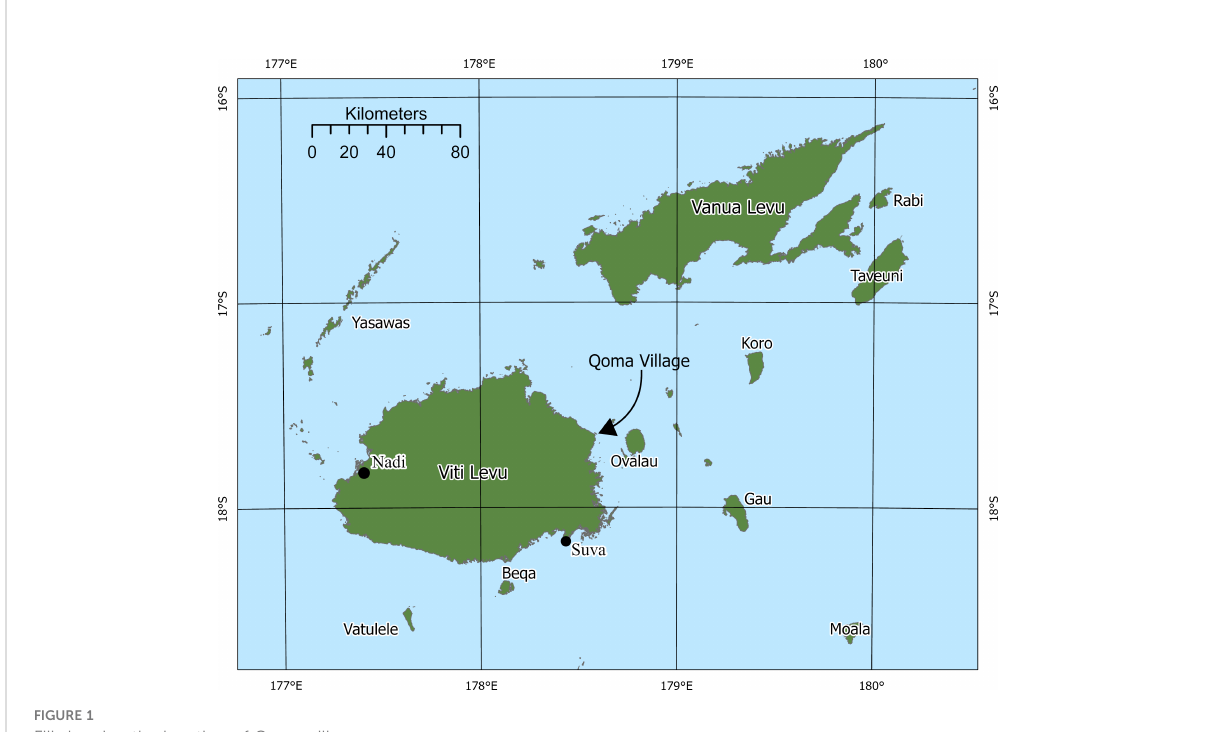
FIGURE 1 Fiji showing the location of Qoma